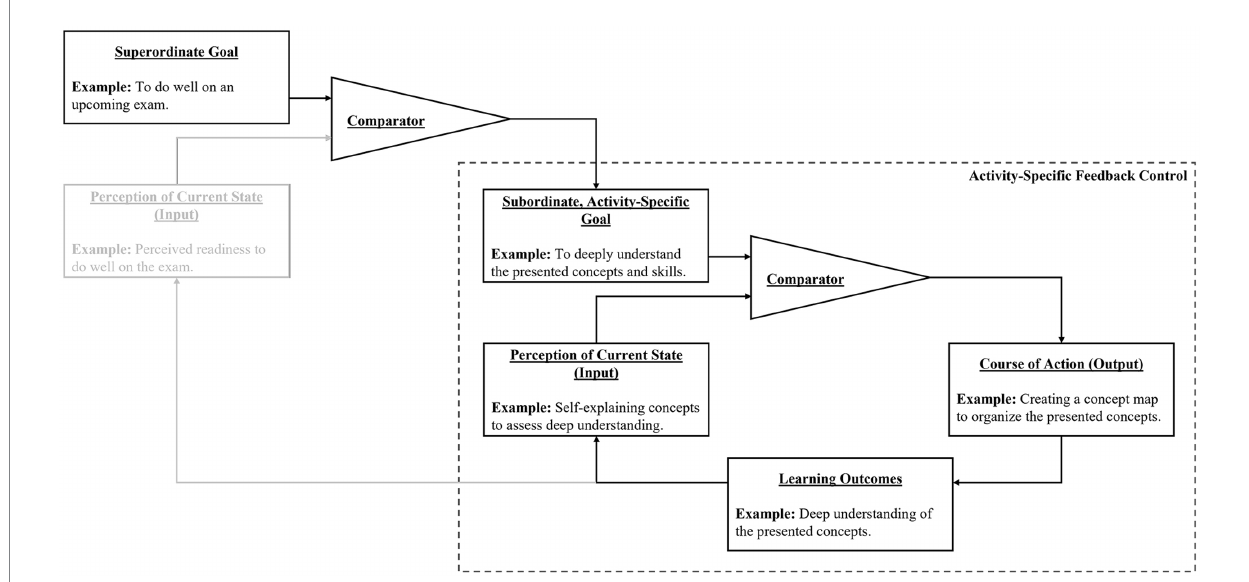
FIGURE 2 Hierarchical organization of feedback loop [adapted from Carver (2015), with